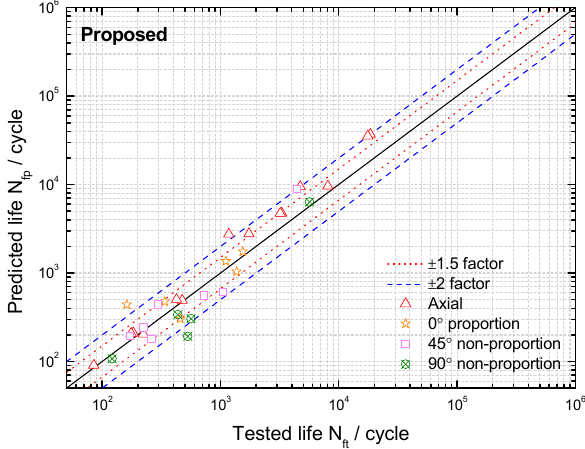
Figure 7. Comparison between tested lives and predicted lives using the proposed damage parameter